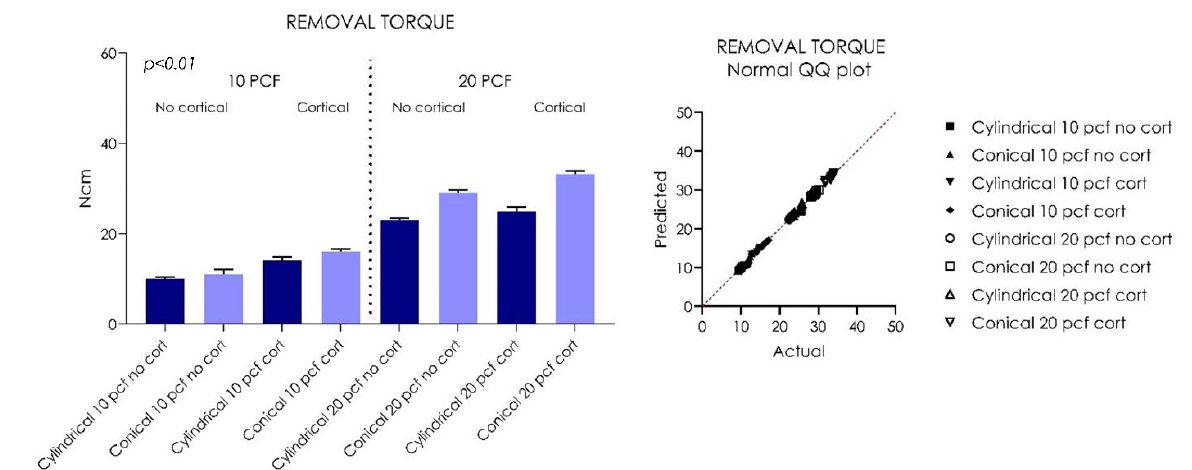
Figure 3. Graph and QQ plot values distribution showing the insertion torque (IT) values of the tested cylindrical and tapered implants.